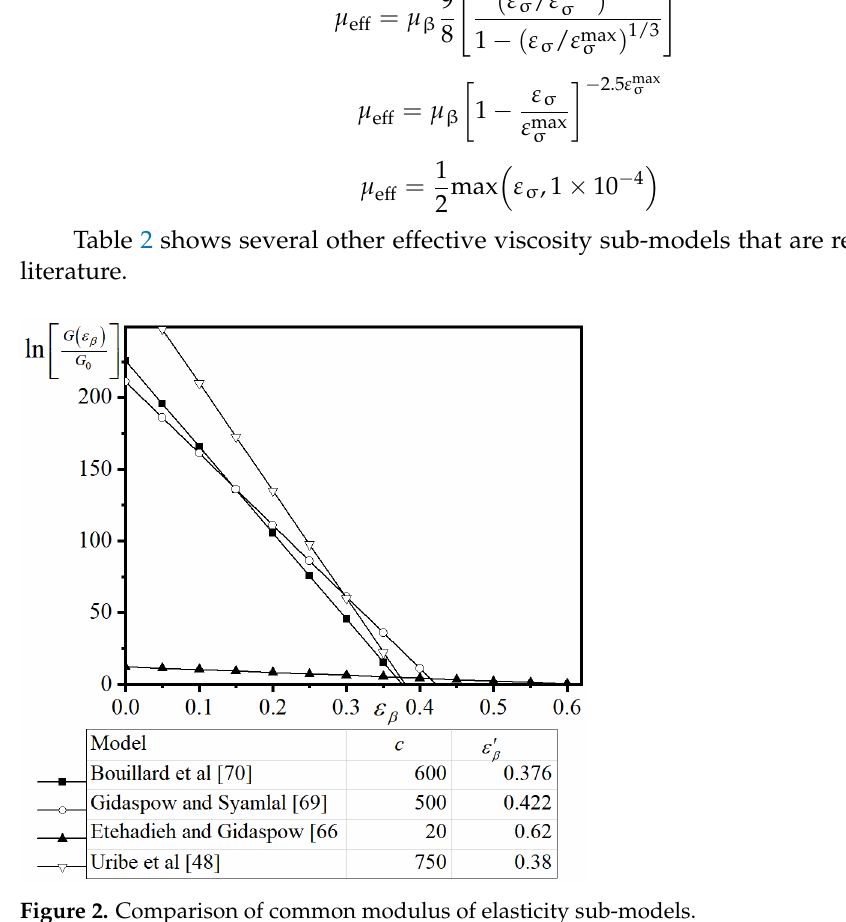
Figure 2. Comparison of common modulus of elasticity sub-models.